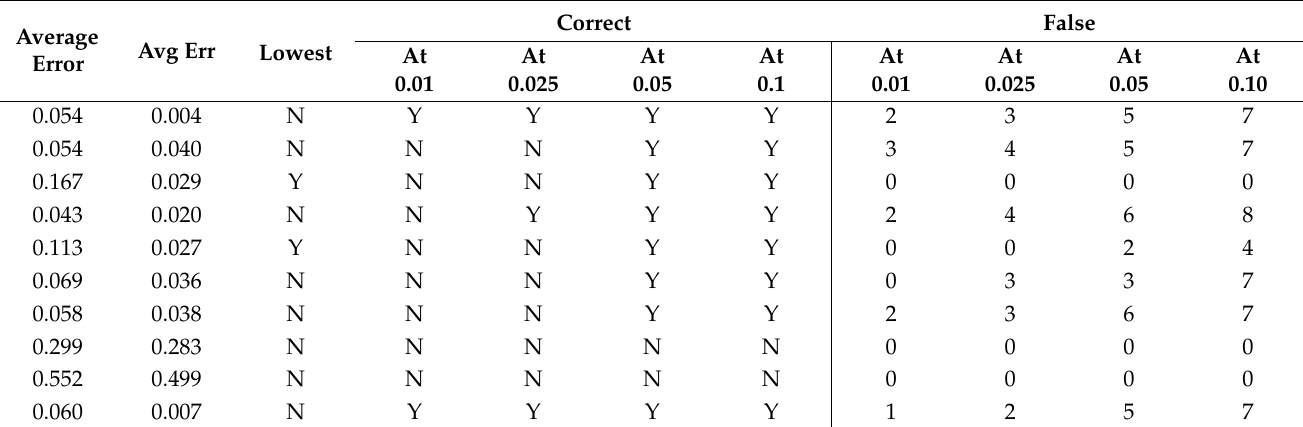
Table A92. Set 2, trials 1–10 summary data (actual PR value).